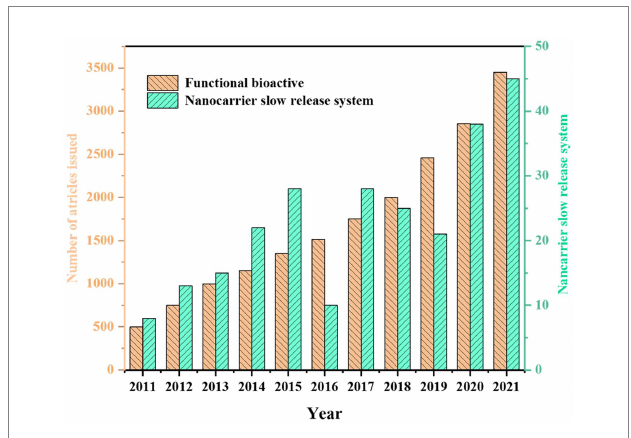
FIGURE 1 Number of publications for the term Functional bioactive and Nanocarrier slow-release system in the last decades (data collected from the Web of